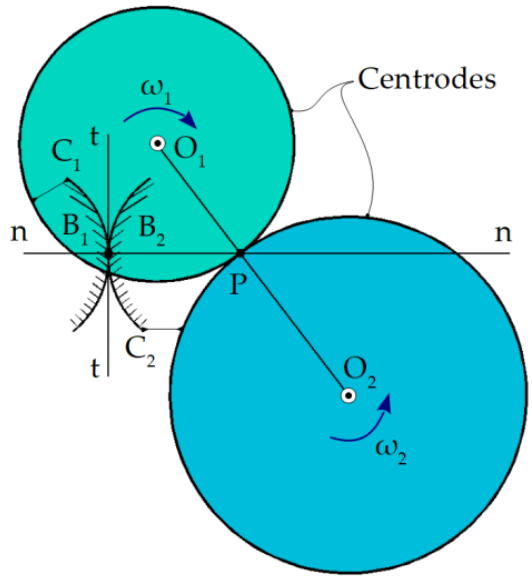
Figure 3. Conjugated profiles.